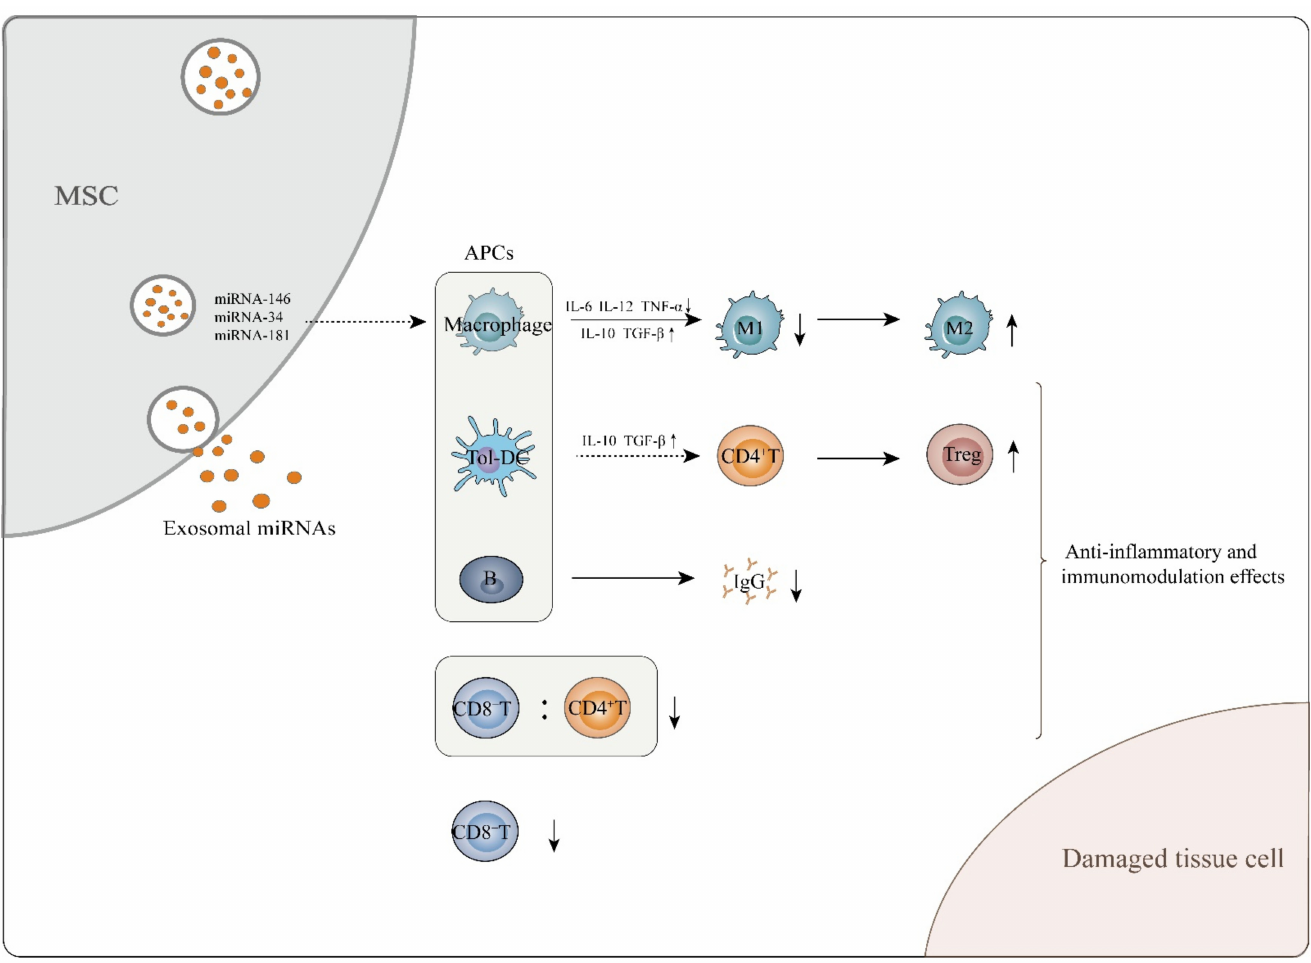
Figure 1. MSC-exosomes exert anti-inflammatory and immunomodulatory effects, which aid in attenuating tissue cell damage. MSC-exosomes perform these functions mainly through interaction of exosomal miRNAs and APCs. They can induce immature and mature DCs to differentiate into tolerogenic DCs, mediating naïve CD4 + T cell differentiation into Tregs. In addition, MSC-exosomes are able to induce macrophages to transform from the M1 to the M2 phenotype while enhancing secretion of M2-related cytokines such as IL-10 and TGF- β and decreasing M1-related cytokine TNF- α , IL-6 and IL-12 levels. With regard to B cells, MSC-exosomes inhibit the maturation and function of B lymphocytes and cause a decrease in IgG secretion. MSC-exosomes also decrease the CD8 + T cell number and the CD8 + /CD4 + T cell ratio in the peripheral blood of in vivo mouse